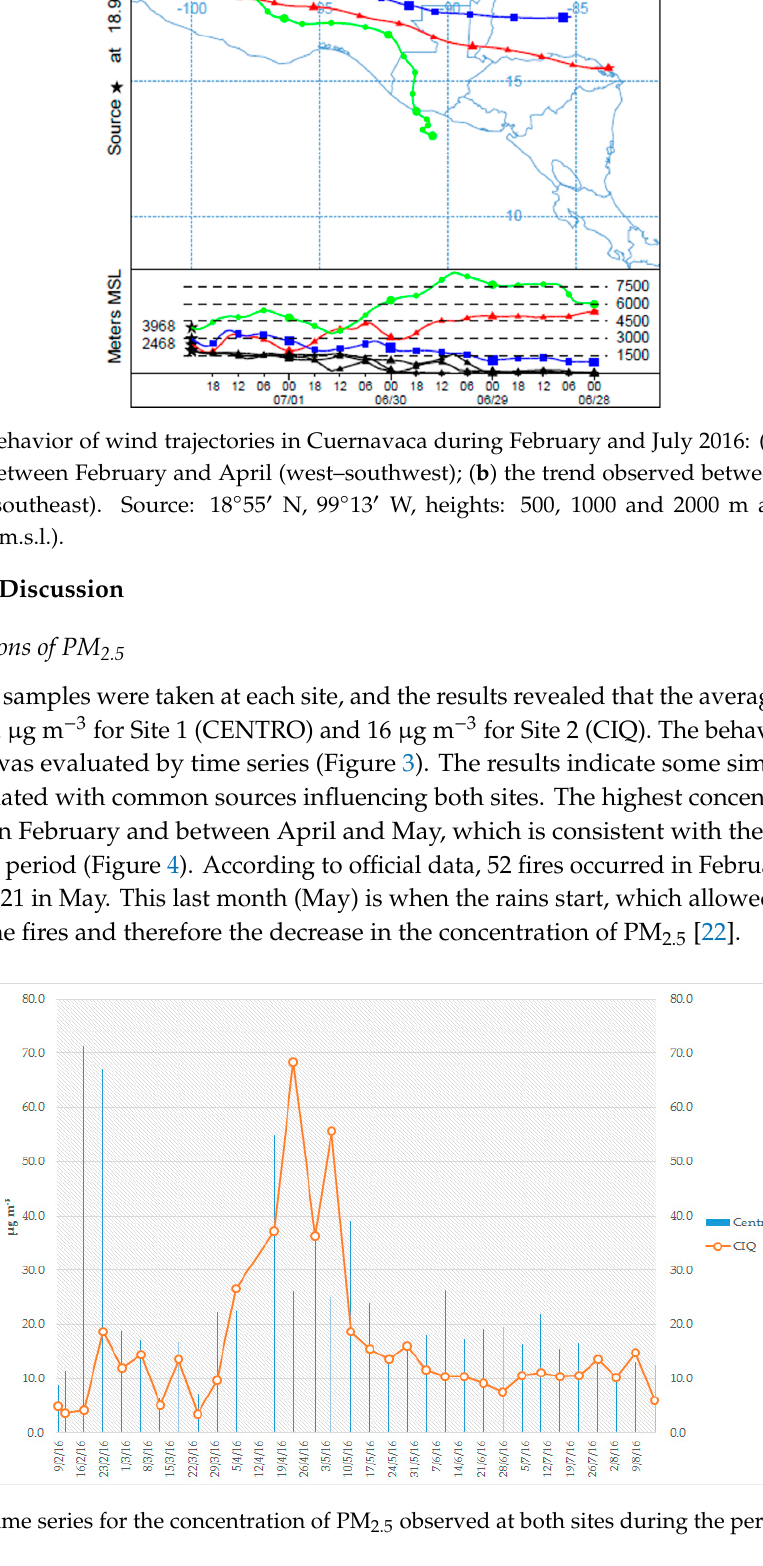
Figure 4. Number of forest fires observed in Morelos State in 2016 [22]. 3.2. Molecular Tracers Associated with Airborne Particles Table 5 summarizes the concentrations of levoglucosan and succinic, glutaric and malonic acids associated with PM 2.5 at both sampled sites in Cuernavaca and their average values with standard deviations, as well as maximum and minimum values. Table 5. Mean concentration and range of the selected molecular markers during study period (ng m − 3 ). Centro